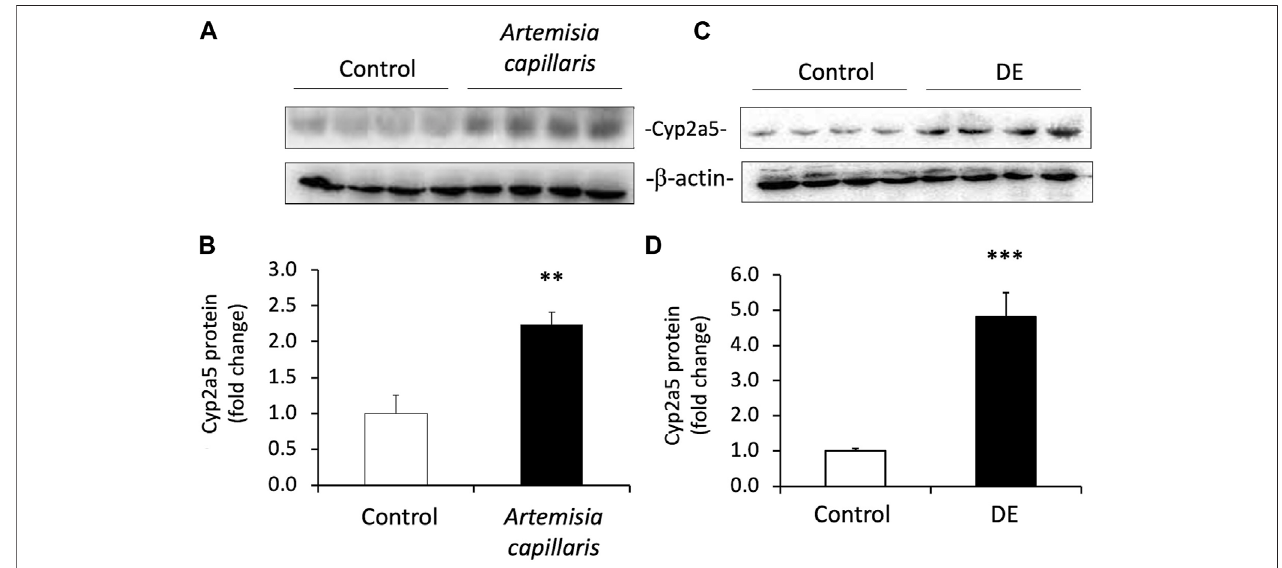
FIGURE 5 | Artemisia capillaris and DE increase hepatic Cyp2a5 protein in mice . Groups of 4 mice were gavaged daily for 3 days with either saline (controls), Artemisia capillaris (10 ml/kg) or DE (100 mg/kg). Panels (A) and (B) , western blots of hepatic Cyp2a5 protein from Artemisia capillaris - or DE-treated mice. Panels (C) and (D) , densitometric quanti fi cation of western blots. The mean difference is signi fi cant from controls at p ≤ 0.01 ** and p ≤ 0.001